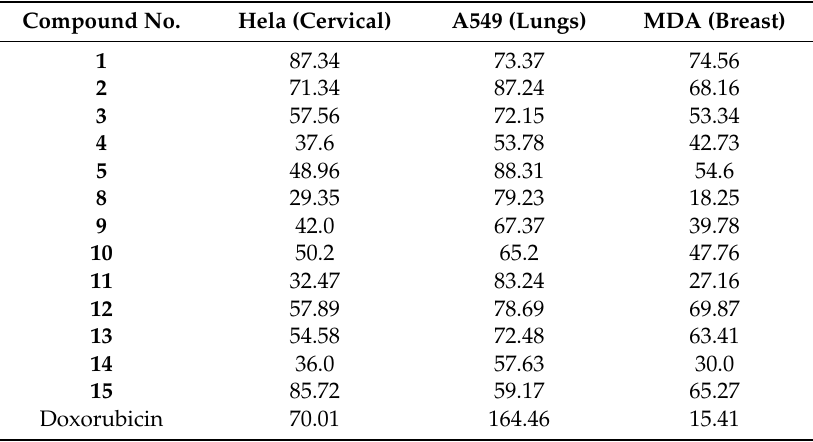
Table 3. IC 50 ( µ g/mL) values of isolated compounds from N. oppositifolia . Compound